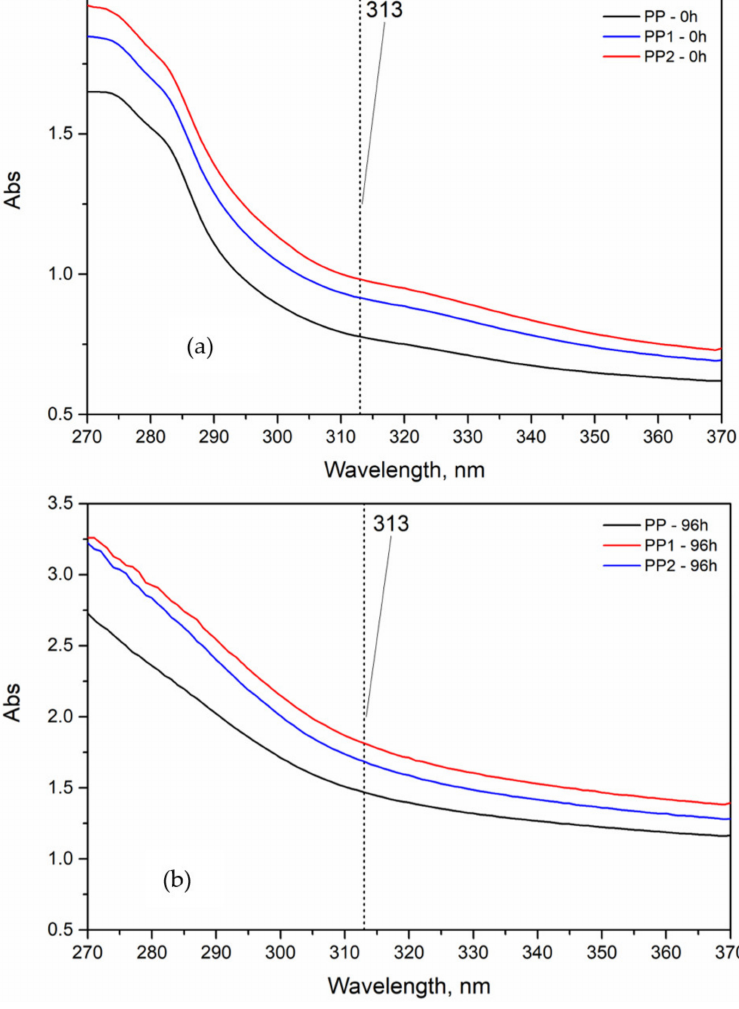
Figure 13. UV absorbance of the polypropylene and polypropylene nanocomposites: ( a ) virgin, ( b ) after 96 h weathering